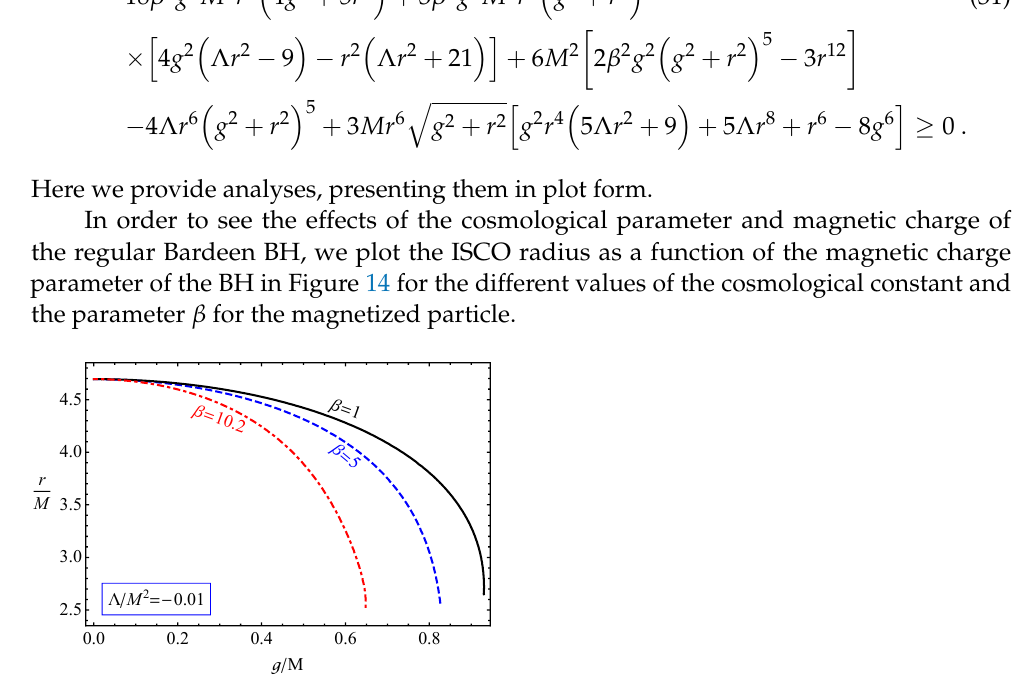
Figure 14. The dependence of the ISCO radius of magnetized particles around the magnetically charged Bardeen black hole in Anti-de Sitter spacetime from the magnetic charge of the black hole for the different values of the parameter β (in the top panel) and cosmological constant (in the bottom